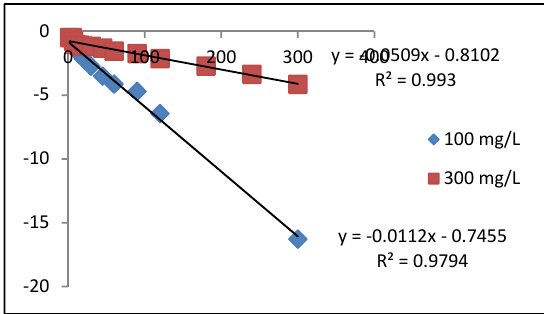
Fig.9. Film diffusion mass transfer model for adsorption of MB